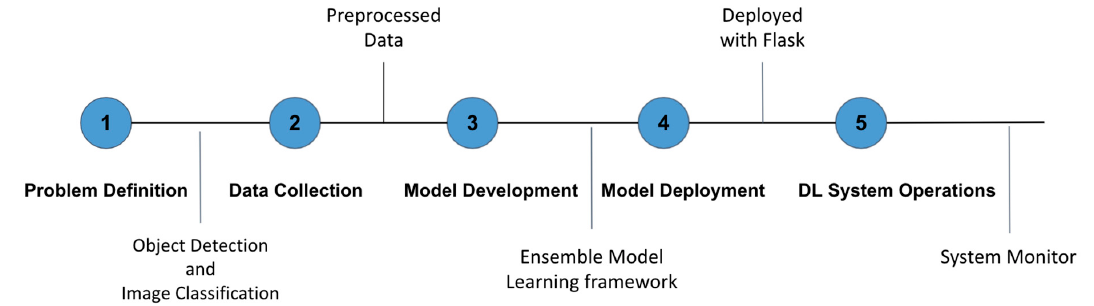
Figure 14. Life Cycle of Spartan System Design.